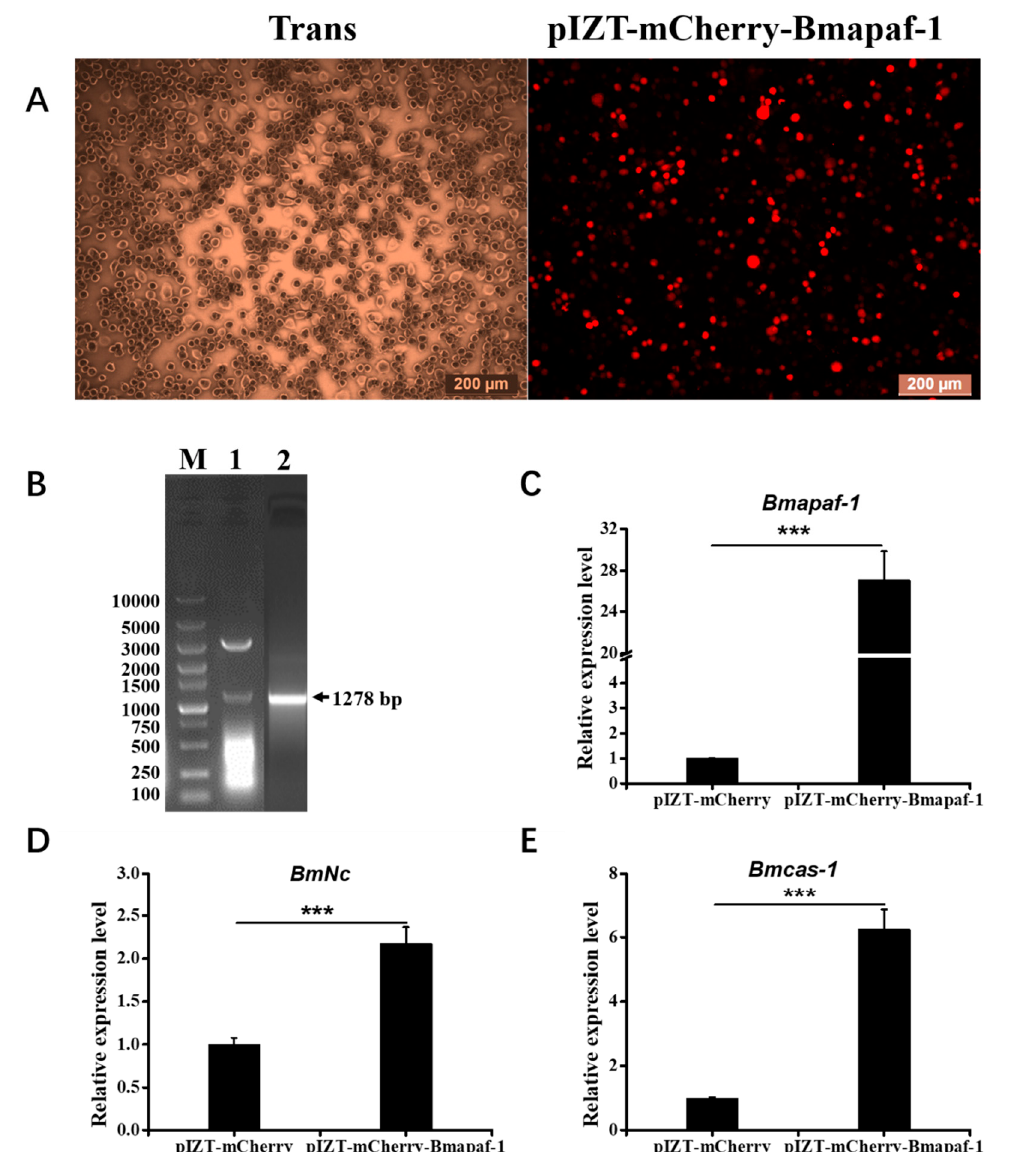
Figure 5. Expression analysis of selected downstream genes after overexpression of Bmapaf-1 at different times in BmN cells. ( A ) Overexpression detection of Bmapaf-1 after transfection with pIZT-mCherry-Bmapaf-1 in BmN cells. Scale bar = 200 μ m. Trans (white), optical transmission. mCherry (Red), fused expression with Bmapaf-1 protein. ( B ) The construction of pIZT-mCherry-Bmapaf-1: (1) validation of the recombinant vector using double enzyme digestion and (2) amplification of the functional domain of Bmapaf-1 . ( C ) The expression level analysis of Bmapaf-1 after transfecting